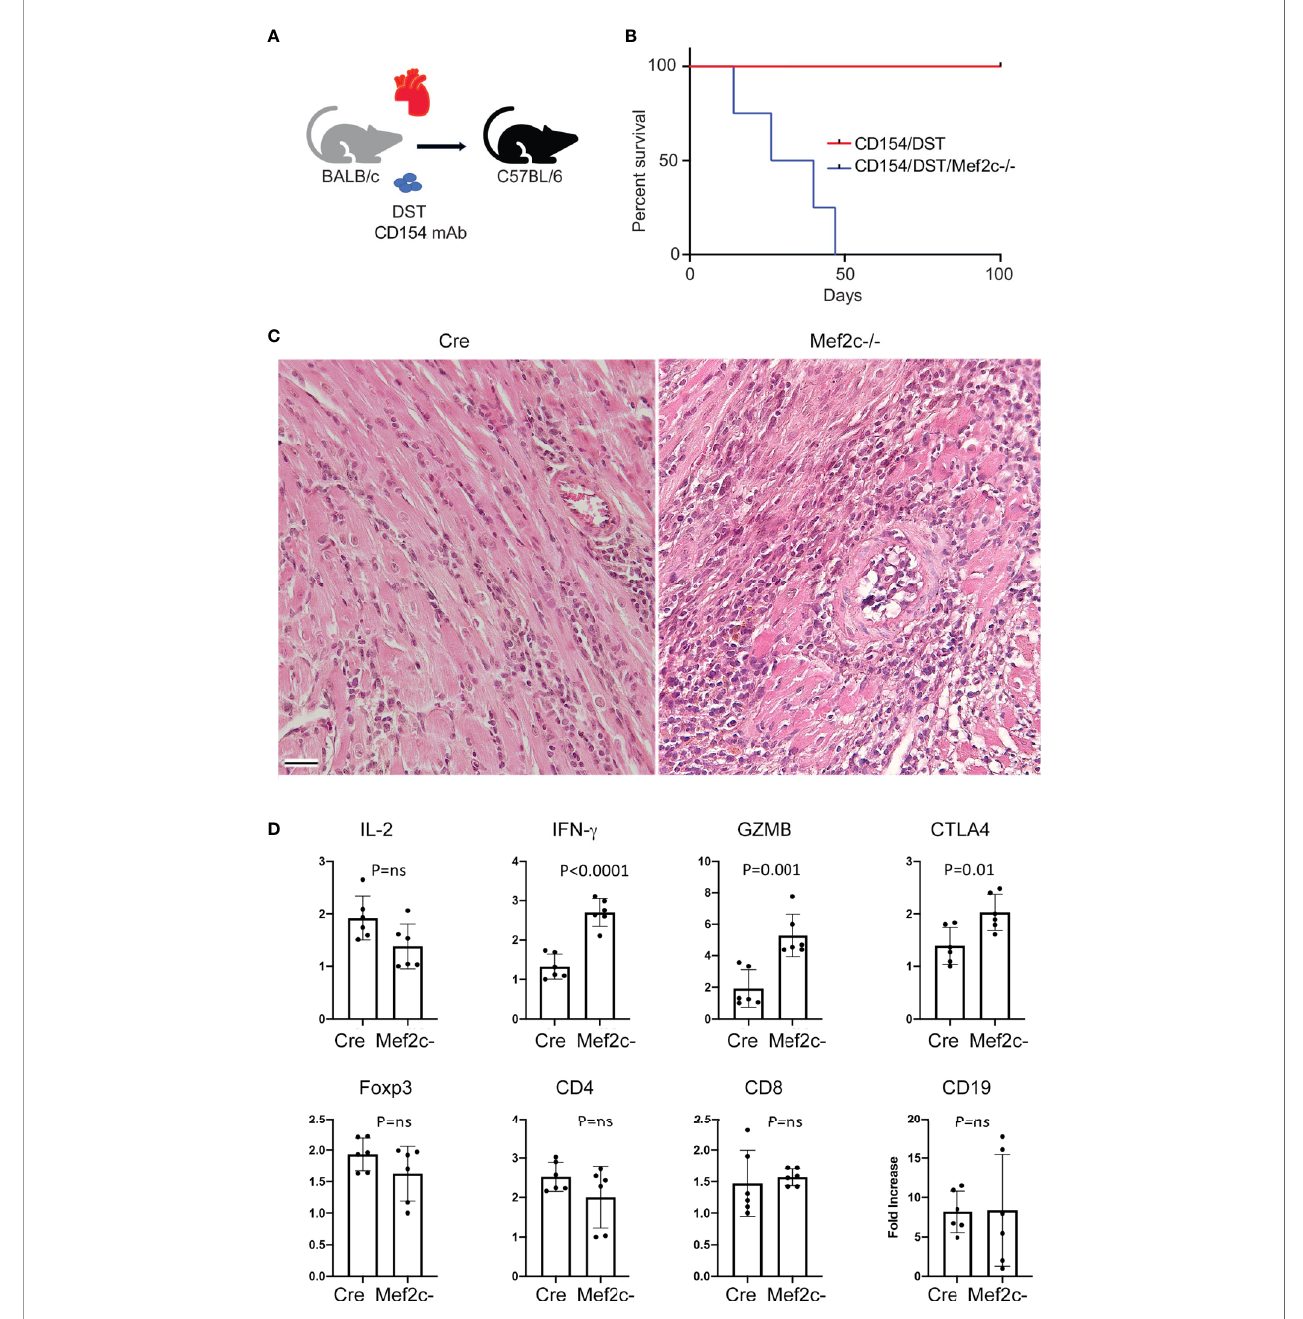
FIGURE 4 | Mef2c deletion dampens Treg function in vivo . (A) Schematic illustrating cardiac allografting procedure. (B) Differently from WT recipients, Mef2c-/- mice acutely rejected cardiac allografts (BALB/c->C57BL/6) despite costimulation blockade with CD154 mAb/DST; n = 5/group (Tukey ’ s multiple comparison test, p < 0.01). The cardiac allografting was repeated twice with similar results. (C) Histology of transplanted hearts show focal interstitial in fi ltrates in WT recipients (Cre) and dense mononuclear in fi ltrates with multifocal myocyte necrosis and vascular injury in conditionally deleted Mef2c-/- recipients (bar = 100 µM). (D) qPCR results of the expression of the indicated genes in samples collected 21 days after cardiac allografting in WT (Cre) and Mef2c – / – mice (n = 6/group). ns, not signi fi